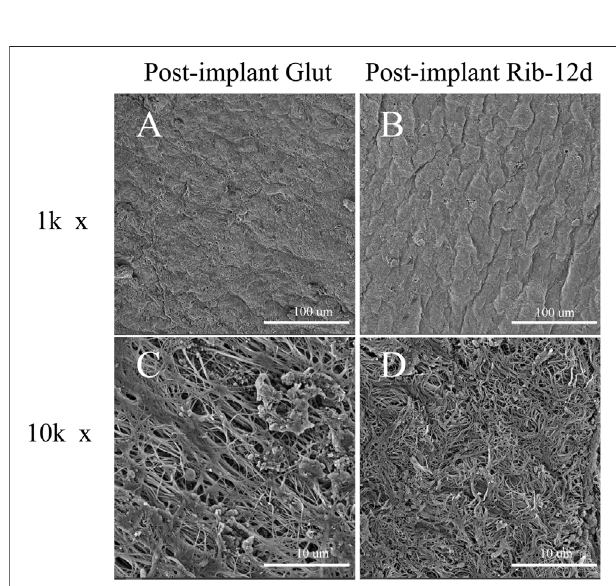
FIGURE 5 | SEM images of BP surface structures after implantation. (A,C) Glut-treatedBPwasimplantedintoratsfor90 days. (B,D) Rib-treated BP was implanted into rats for 90 days. Scale bars: 100 μ m (A,B) and 10 μ m (C,D) .